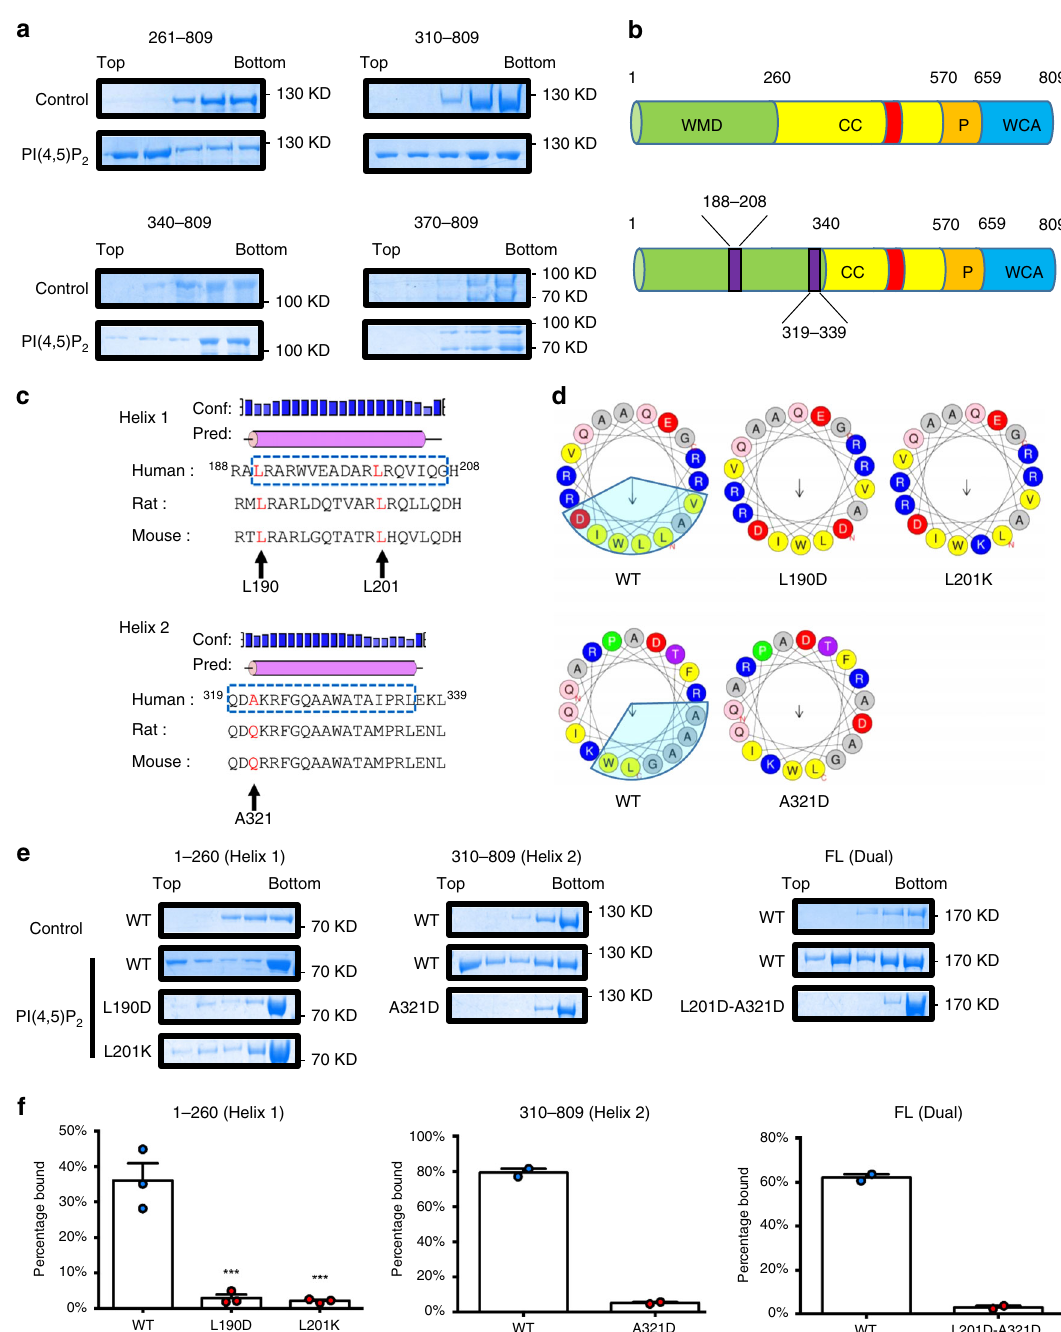
Fig. 6 WHAMM binds to PI(4,5)P 2 through two conserved amphipathic helixes. a Flotation assays to identify the membrane-binding regions in WHAMM beyond the originally identi fi ed WMD (1-260) domain. Liposomes with only DOPC-DOPE were used as the control. b Comparison of the domain structure of WHAMM based on a previous model (top) and proposed in current work (bottom). Two regions suspected to be responsible for the membrane interaction of WHAMM are highlighted in purple. c Sequence alignment of helix 1 and helix 2, along with their secondary structure prediction 39 . The indicated point mutations (arrows) were introduced at the sites highlighted in red. The dashed box shows the region used to generate the helical wheel in the next panel. d Corresponding helical wheels of helix 1 and helix 2 generated using HELIQUEST 40 . The hydrophobic face is highlighted as a light blue sector. The black arrows indicate the direction of hydrophobic moments. The mutations that disrupt the hydrophobic face are also shown. e FL WHAMM and fragments containing helix 1 (1-260) or helix 2 (310-809) with and without the indicated mutations were puri fi ed and incubated with liposomes containing DOPC-DOPE only or with 15% PI(4,5)P 2 and applied to the fl otation assay. Each fraction was collected carefully, then proteins were separated by SDS-PAGE and visualized using Coomassie blue. f Band density in the top fraction from each experiment in e was measured and normalized with total input using ImageJ. The proportion of protein bound to liposomes was compared between the mutants and WT from two or three independent experiments. Error bars indicate SEM. For 1-260 ( n = 3), results were compared using one-way ANOVA followed with Holm-Sidak ’ s multiple comparisons test. *** p < 0.001. For 310-809 ( n = 2) and FL ( n = 2). Source data are provided as a Source Data fi